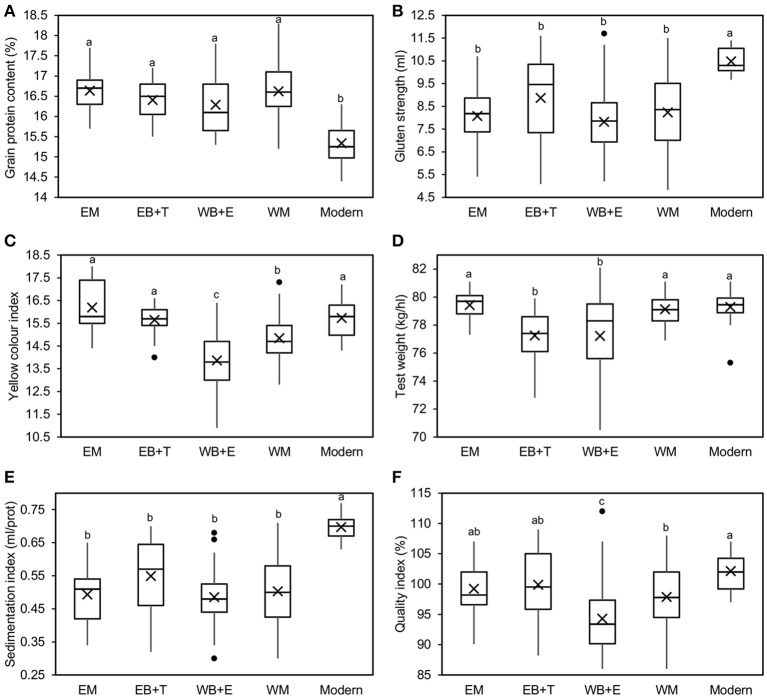
Boxplots for mean comparison of pasta-making quality traits [(A) grain protein content, (B) gluten strength, (C) yellow color index, (D) test weight, (E) sedimentation index and (F) quality index] in a collection of 183 durum wheat cultivars divided into five genetic SPs and grown for 3 years. EM, eastern Mediterranean; EB+T, eastern Balkans and Turkey; WB+E, western Balkans and Egypt; WM, western Mediterranean. Means within boxplots with different letters are significantly different at P < 0.05 following a Tukey test. × represents the mean value and ∙ represents outlier values.